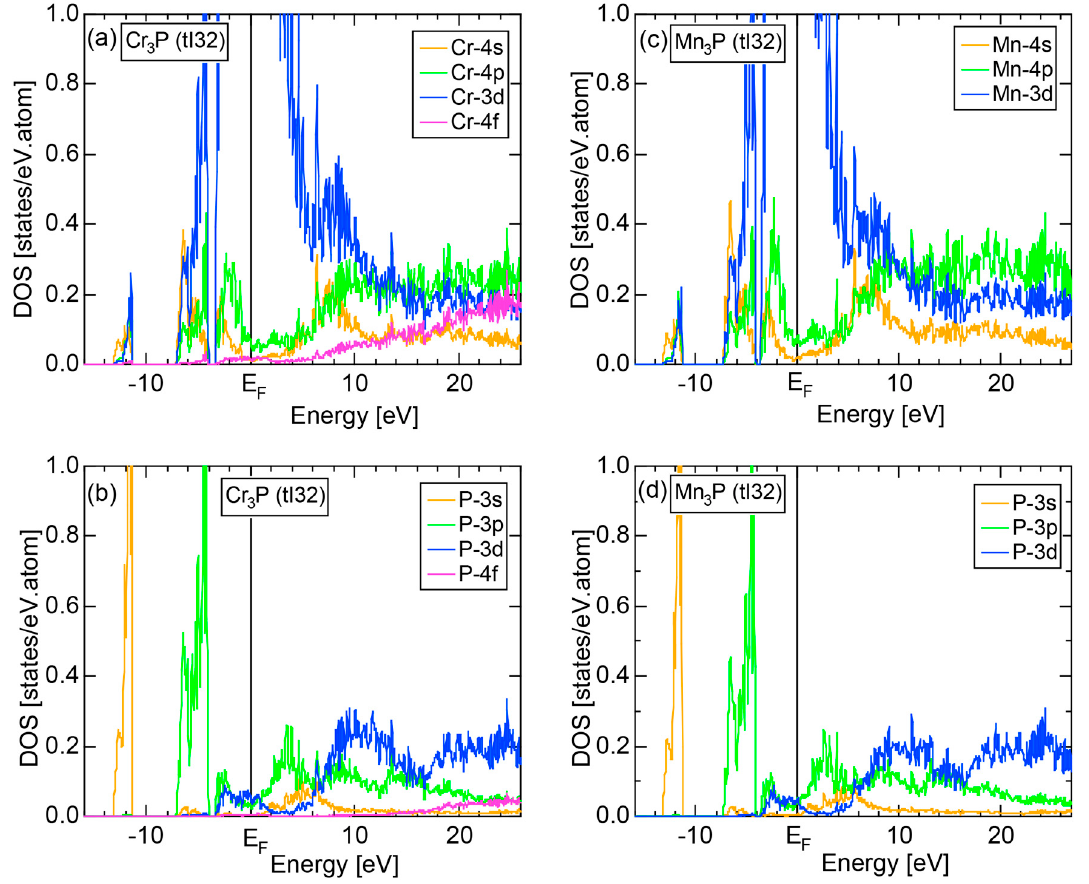
Figure 84. ( a ) Cr- and ( b ) P-pDOSs for Cr 3 P (tI32) and ( c ) Mn- and ( d ) P-pDOSs for Mn 3 P (tI32) [11].